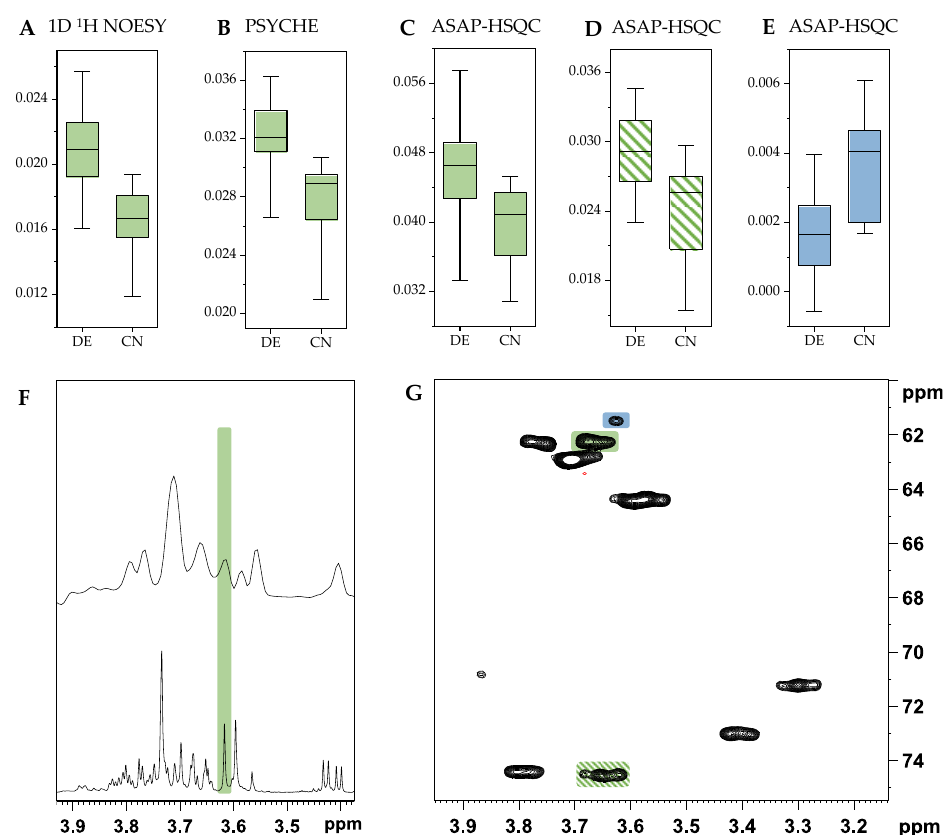
Figure 8. ( A ): Box-whisker plot showing the centered and scaled values of the bucket at 3.61 ppm in the 1D 1 H NOESY spectra from German (DE) and Chinese (CN) walnut samples. ( B ): Box-whisker plot of the same bucket (3.62 ppm) in the PSYCHE spectra from German and Chinese samples. ( C ): Box-whisker plot of one bucket of sucrose at 3.66/62.2 ppm in the ASAP-HSQC spectra from German and Chinese samples (highlighted green). ( D ): Box-whisker plot of another bucket of sucrose at 3.64/74.5 ppm in the ASAP-HSQC spectra (highlighted green hatched). ( E ): Box-whisker plot of the bucket at 3.63/61.4 ppm in the ASAP-HSQC spectra (highlighted blue). ( F ): Relevant region of the PSYCHE NMR spectrum (upper part) and 1D 1 H NOESY spectrum (lower part) with the bucket used for the box-whisker plots highlighted in green. ( G ): Carbohydrate region of the ASAP-HSQC spectra with the buckets used for the box-whisker plot highlighted.